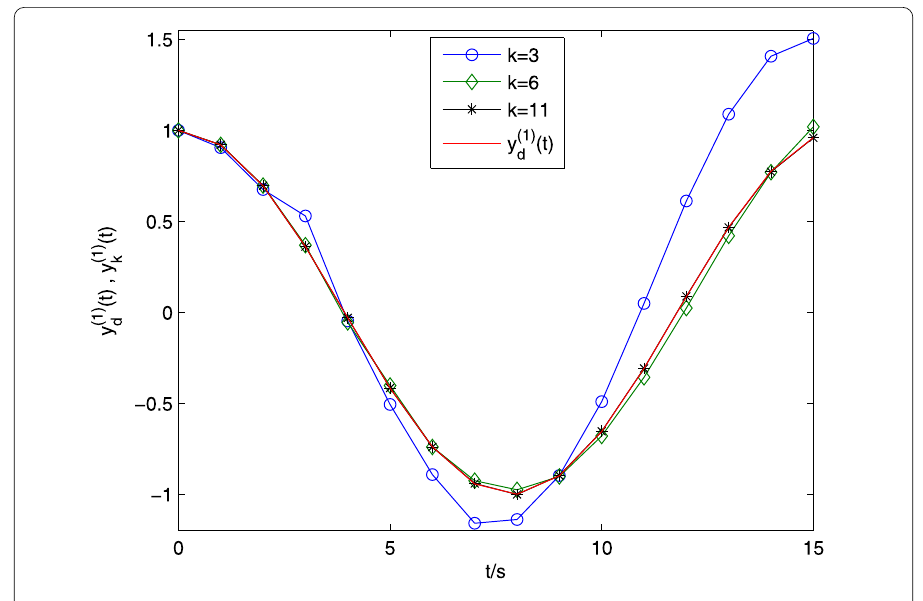
Figure 5 The tracking performance of the system output y (2) iterations by using the learning algorithm